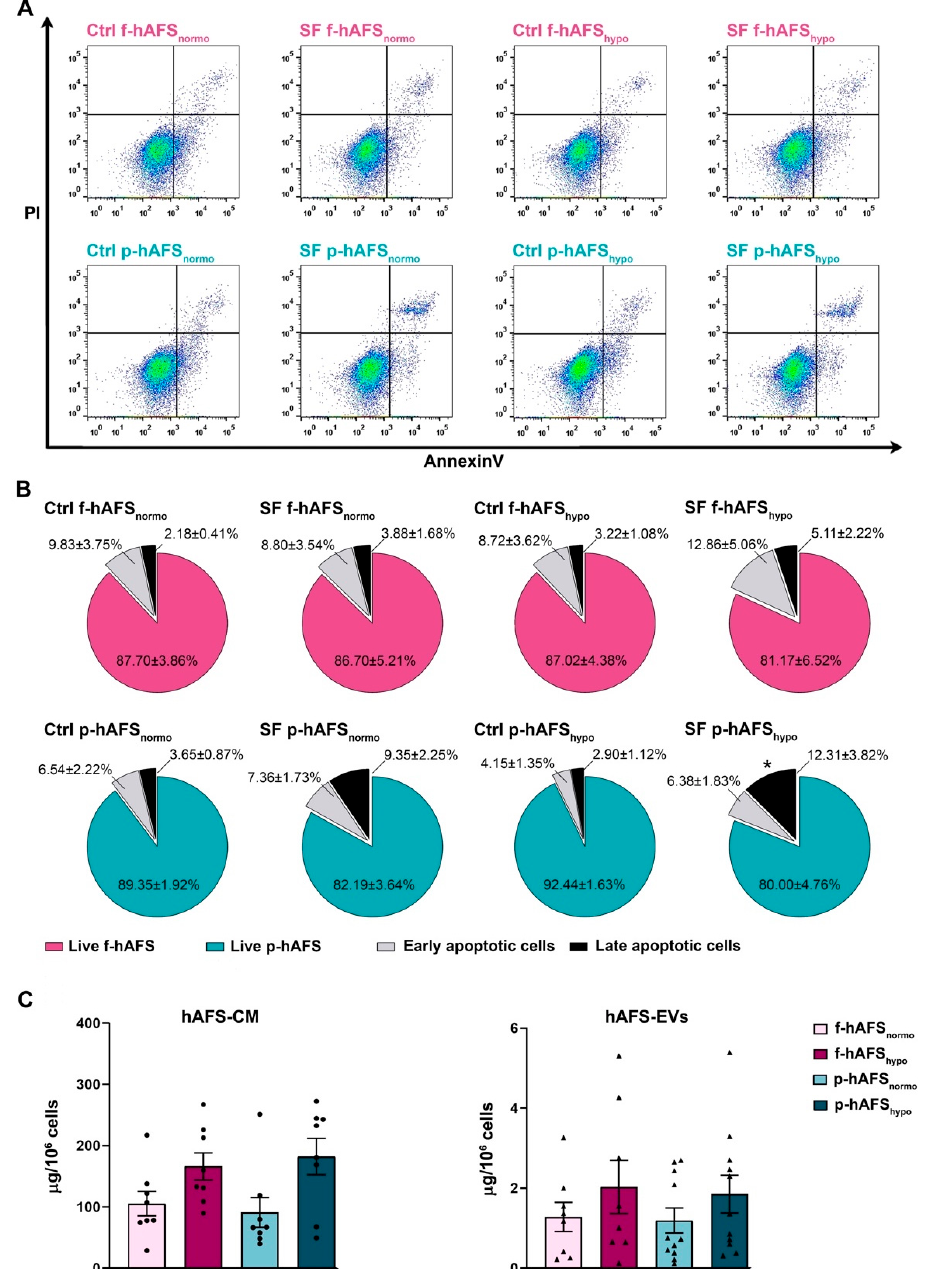
Figure 3 . Evaluation of the preconditioning effect on fetal- and perinatal hAFS viability and on secretome yield. ( A ) Apoptosis analysis by flow cytometry evaluation of PI and Annexin V expression on f-hAFS and p-hAFS after 24 h preconditioning in either 20% O 2 normoxic condition compared to the 1% O 2 hypoxic condition, and in complete control (Ctrl) medium versus serum-free (SF) medium (Ctrl f-hAFS normo ; Ctrl f-hAFS hypo ; SF f-hAFS normo ; SF f-hAFS hypo ; Ctrl p-hAFS normo ; Ctrl p-hAFS hypo ; SF p-hAFS normo ; SF p-hAFS hypo , respectively). ( B ) Pie charts of live, early apoptotic and late apoptotic f-hAFS ( n = 4 experiments, upper panel) and corresponding p-hAFS ( n = 6 experiments, lower panel); late apoptotic Ctrl p-hAFS hypo vs SF p-hAFS hypo * p = 0.0392; no statistically significant differences were detected among all other comparisons. ( C ) Protein concentration of hAFS secretome yield obtained from serum-free culture conditions by BCA assay. Left panel refers to the entire secretome formulation, namely the in vitro hAFS-conditioned medium (hAFS-CM). Right panel refers to hAFS-EV formulations (hAFS-EVs); n = 8 experiments for f-hAFS-EVs and n = 11 experiments for p-hAS-EVs. All values are expressed as mean ± s.e.m of independent